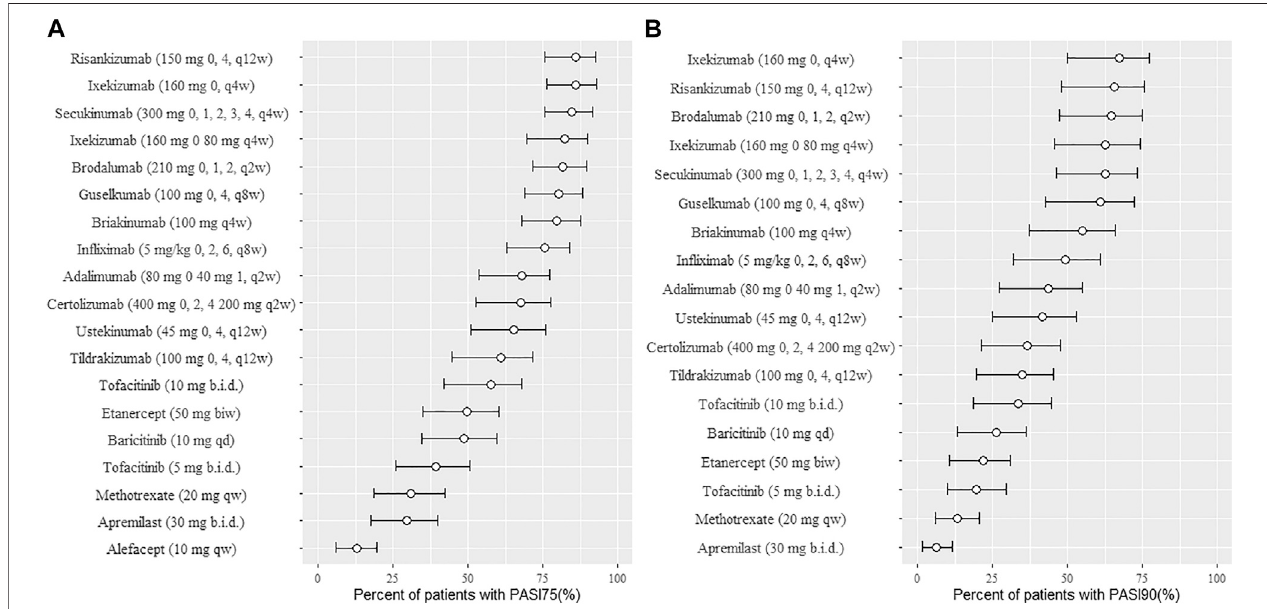
FIGURE3| Ranking oftreatmentsfor psoriasispresentedasmedian responserateforPASI75 (A) and PASI90 (B) at week12(from hightolow). Circlesrepresent the median valueand horizontal bars are95%intervalsfrom modelsimulation( N (cid:1) 1,000)assuming average bodyweight 90 kg;PASI75, ≥ 75%reduction from baseline Psoriasis Area and Severity Index score; PASI90, ≥ 90% reduction from baseline Psoriasis Area and Severity Index score; qw, once weekly; q2w, once every 2 weeks; q4w, once every 4 weeks; q8w, once every 8 weeks; q12w, once every 12 weeks; biw, twice weekly; qd, once daily; b. i.d., twice daily.